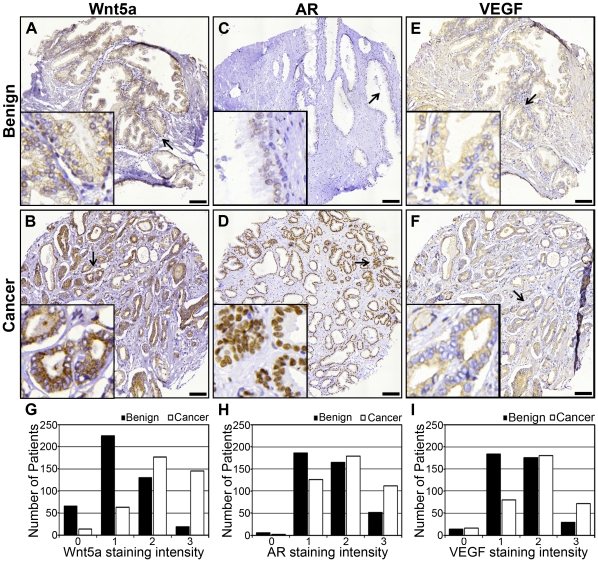
Immunohistochemical expression of Wnt5a, AR and VEGF in tissue microarray cores of primary tumors and benign specimens obtained after radical prostatectomy.
A & B) The panels show representative Wnt5a immunostainings in benign and cancer tissue areas from the same patient C & D) The panels show representative nuclear AR immunostainings in benign and cancer tissue areas E & F) The panels outline VEGF immunostaining in benign and cancer tissue areas from the same patient. All inserts in the panels depict magnification (40×) images of the area indicated by the arrow in the larger image seen at 15× magnification. G, H & I) The panels outline graphical illustrations of Wnt5a, AR and VEGF protein expressions in benign and cancer samples in PCa patients. The bar in each panel outlines 100 µm.